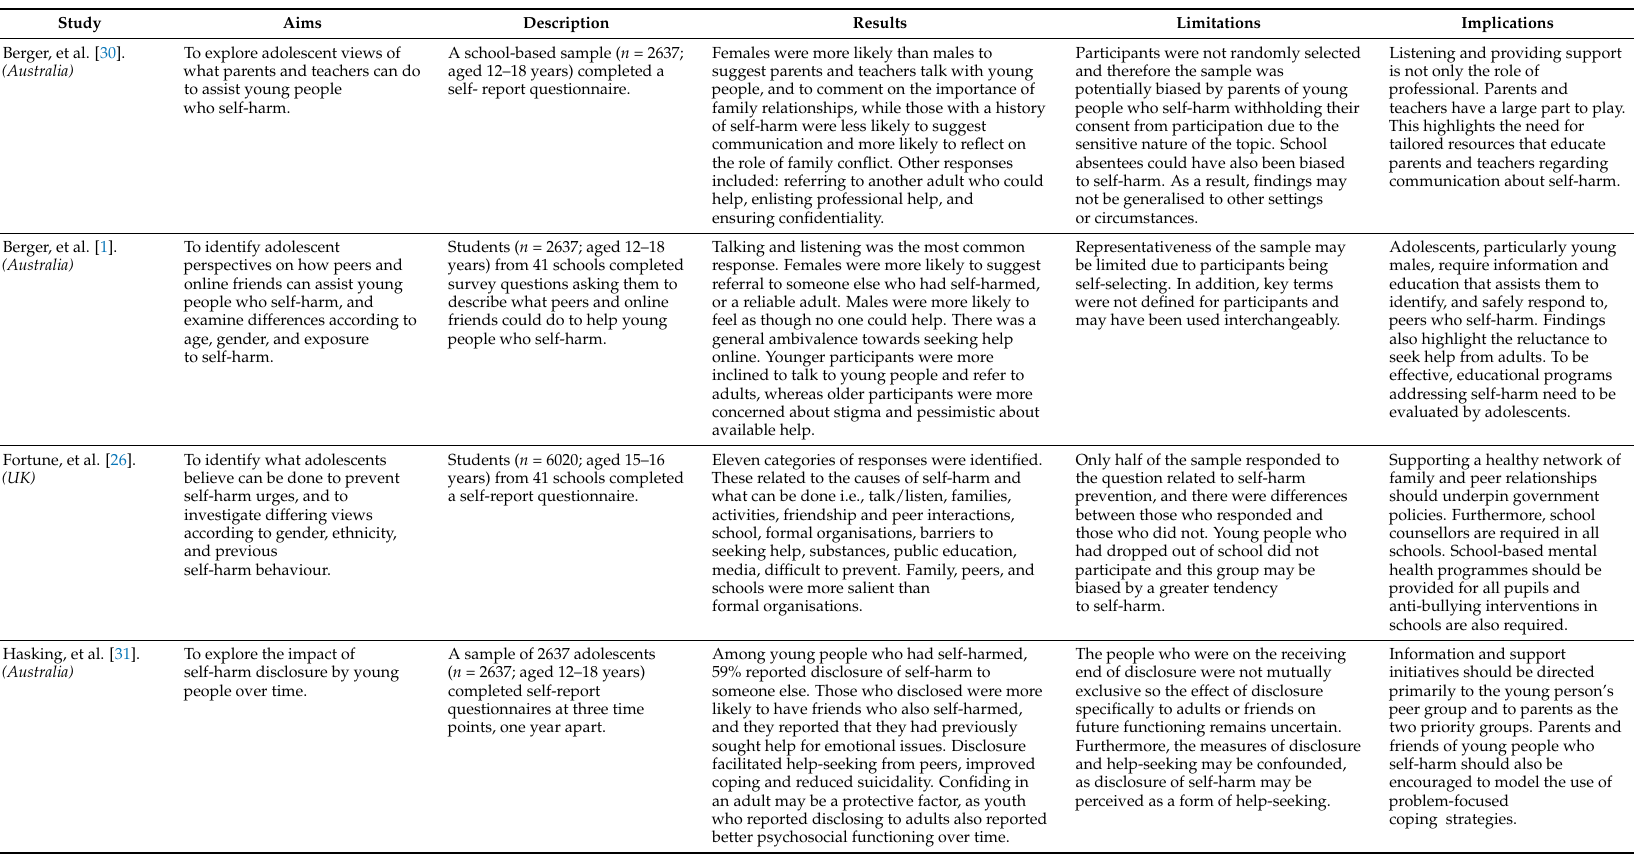
Table 1. Articles that examined the perspectives of young people ( n =